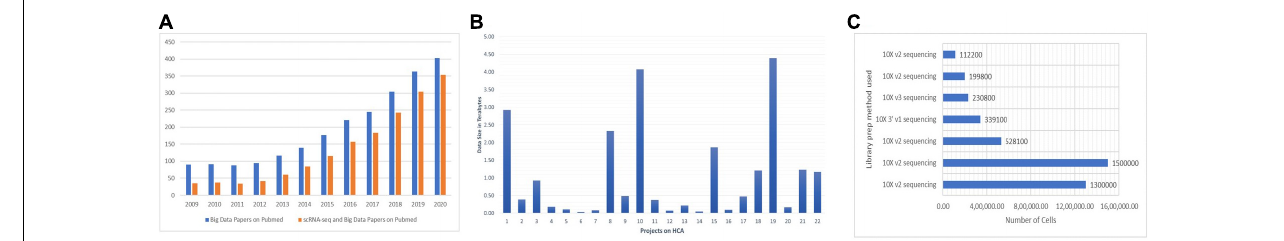
FIGURE 2 | (A) There is a steep rise every year for the publications of studies addressing the big data and SC-RNA-seq. For big data papers on PubMed, we used the query “ [big data (All Fields) AND MapReduce (All Fields) AND Hadoop (All fields)] .” For SC-RNA-seq and big data papers on PubMed, we used “ [(scRNA-seq OR Big Data) OR (Single-cell AND big data)] .” (B,C) Numbers were collected from the Human Cell Atlas Data portal of some exemplary projects.